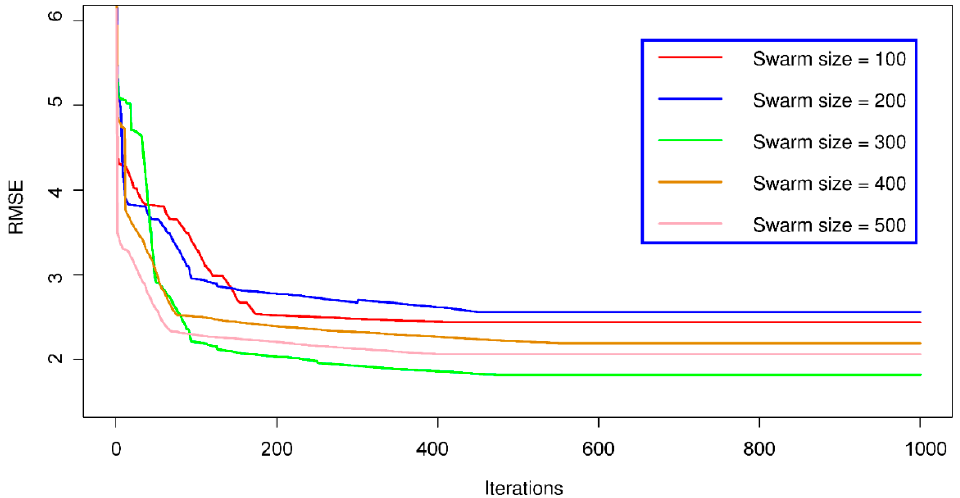
Figure 10. Particle swarm optimization (PSO-ANN) performance for estimating HL of EEB systems in the training process.